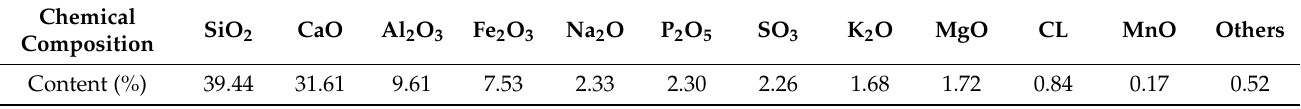
Table 5. The chemical composition of MSWI BA.